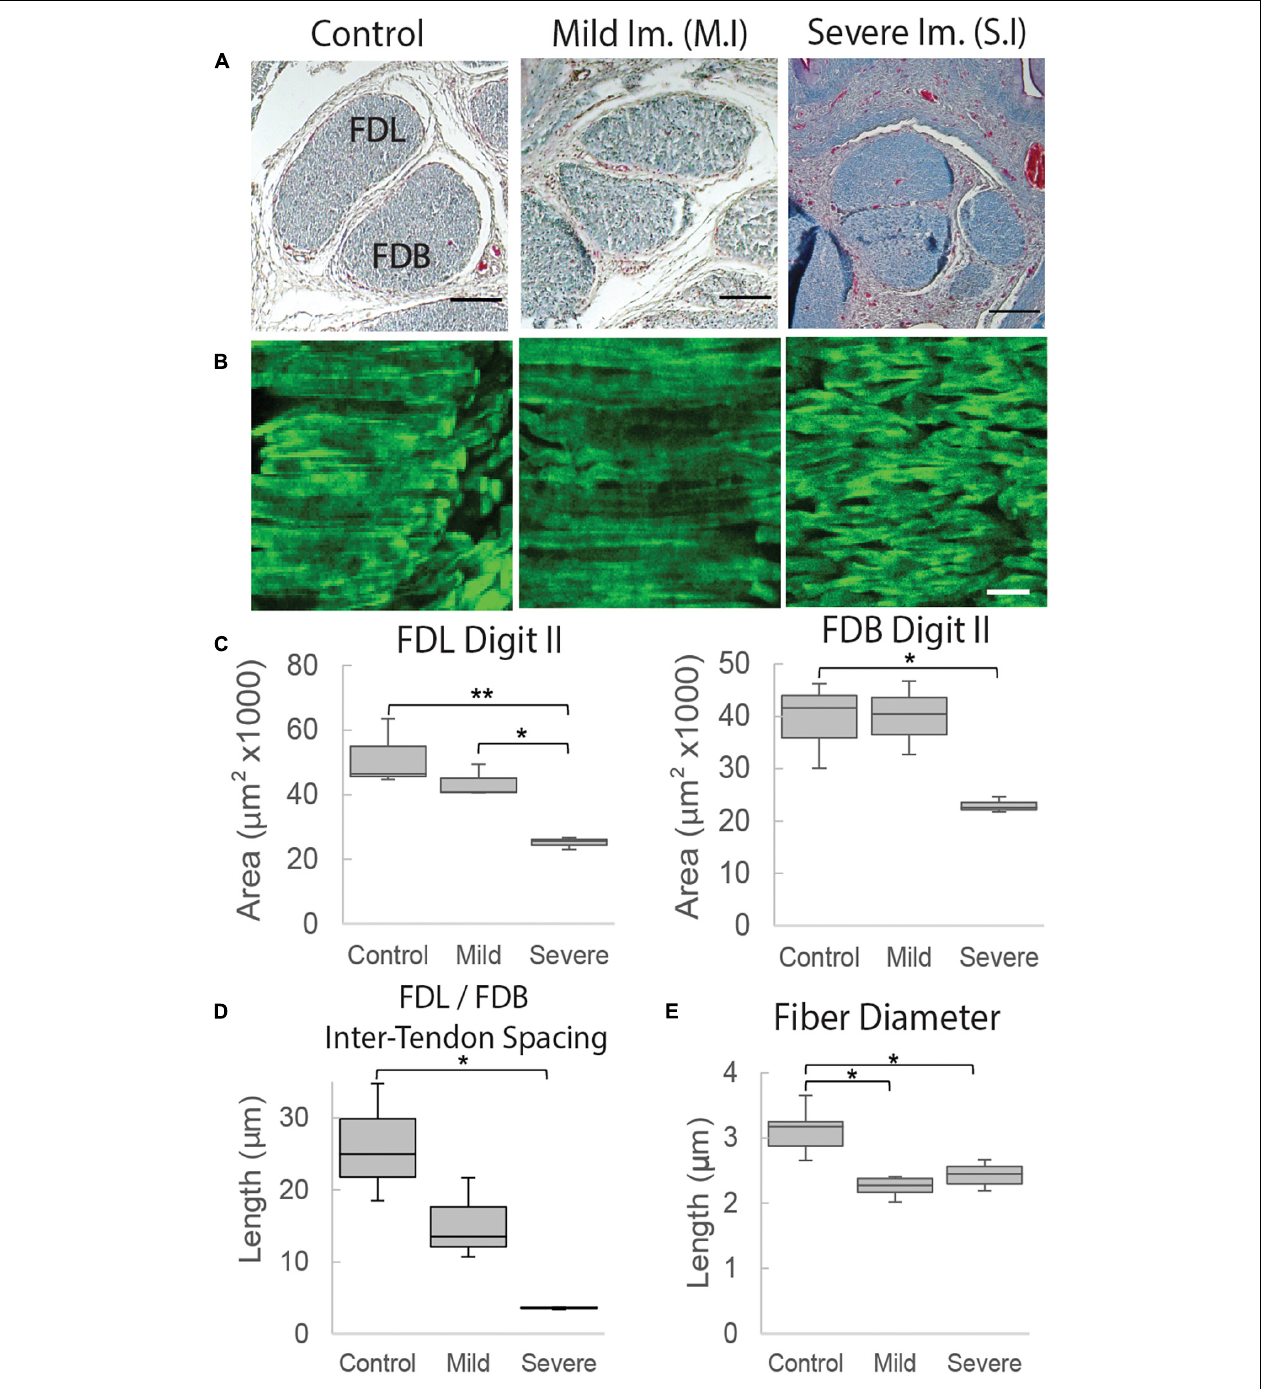
FIGURE 7 | Structural organization of tendons at E17 (HH43) is altered following immobilization by rigid paralysis (DMB treatment). (A) Representative cross-sections through the flexor digitorum longus (FDL) and brevis (FDB) digit II tendons stained with Masson Trichrome. Images, from the left, show control treatment, mild Immobilization (Mild Im.) and severe immobilization (Severe Im.) treatment conditions (see Figure 1 ). Scale bar 100 µ m. (B) Representative longitudinal sections stained with collagen binding protein (CNA35-eGFP) under the same conditions as (A) , as indicated. Scale bar 10 µ m. (C) Box plots represent cross sectional area measurements of the FDL and FDB digit II tendons showing significant reduction following severe rigid paralysis (plot whiskers represent min and max data values). (D) Box plot representing the spacing measurement between tendons with significant reduction under severe immobilization conditions. (E) Box plot representing fiber diameter measurements with significant reduction following both mild and severe immobilization treatments. Statistical analysis was carried by univariate ANOVA followed by Tukey post hoc tests. n = 3, all groups in (C,D) ; in (E) , n = 6 (control), n = 4 (S.I), and n = 2 (M.I). * p ≤ 0.05, ** p ≤ 0.001.